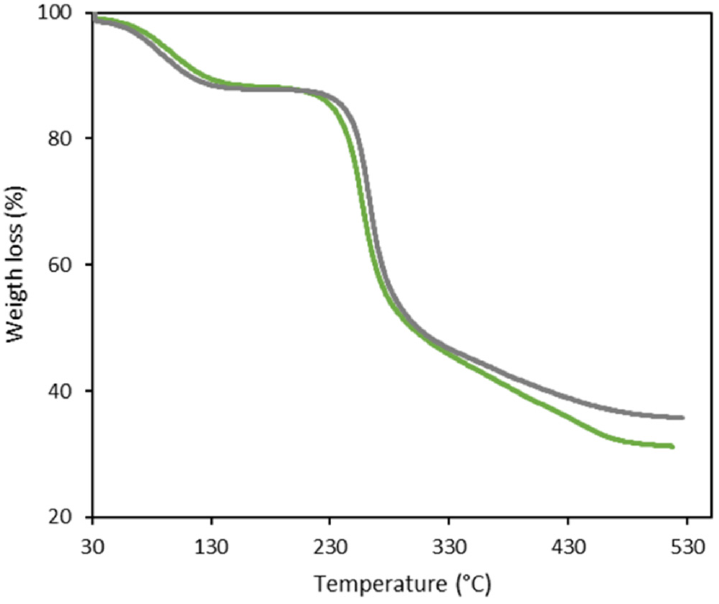
Figure 2. Thermogravimetric curves of FucoPol (green line) and d-FucoPol (grey line).